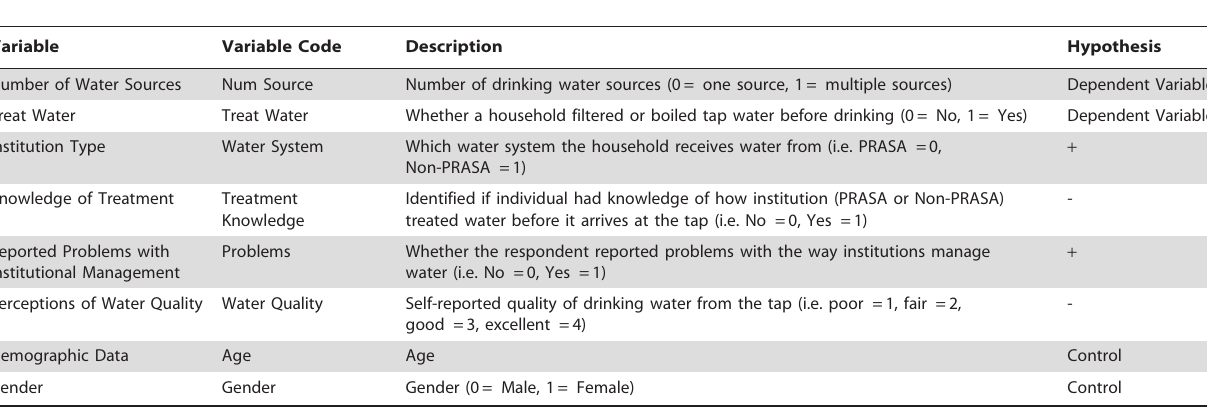
Table 1. Description and hypothesized relationship for each of the variables considered in our statistical models.